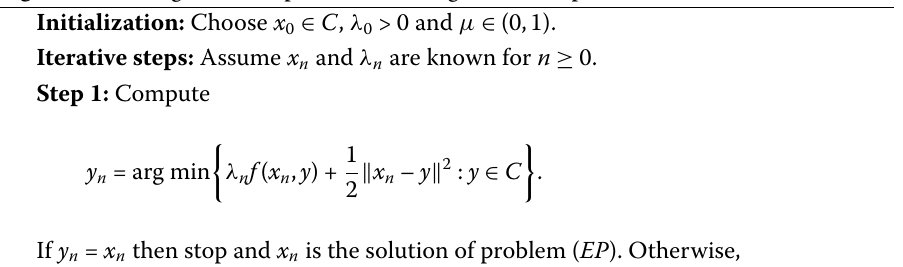
Algorithm 1 Subgradient explicit iterative algorithm for pseudomontone